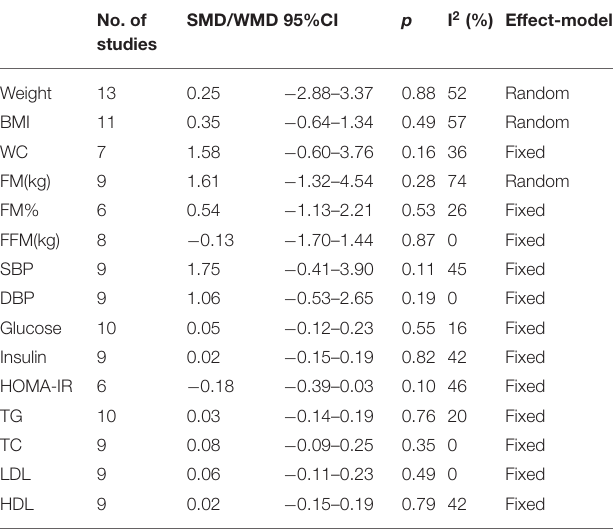
TABLE 6 | Physical and biochemical parameters of IF vs. CR in patients with BMI ≥ 25 kg/m 2 . No. of